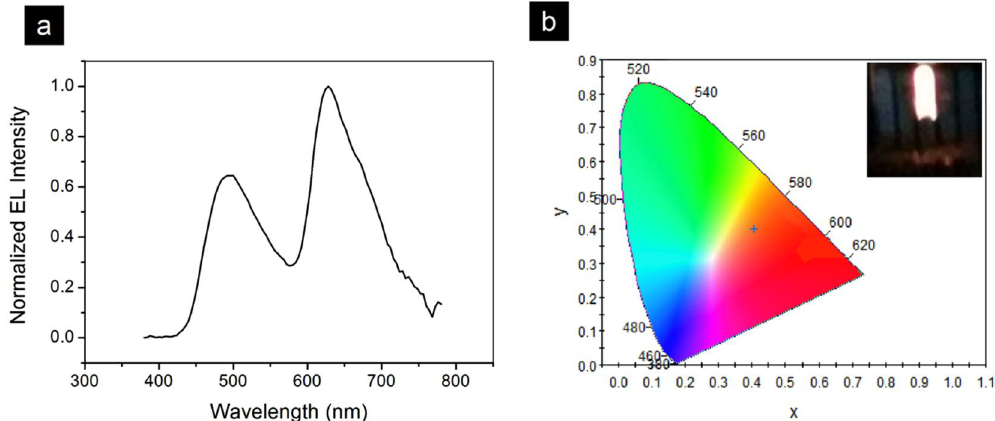
Figure 4. ( a ) EL spectrum for white LEC; ( b ) CIR coordinates for the white light emission. The inset shows a photo of the device emitting white light.